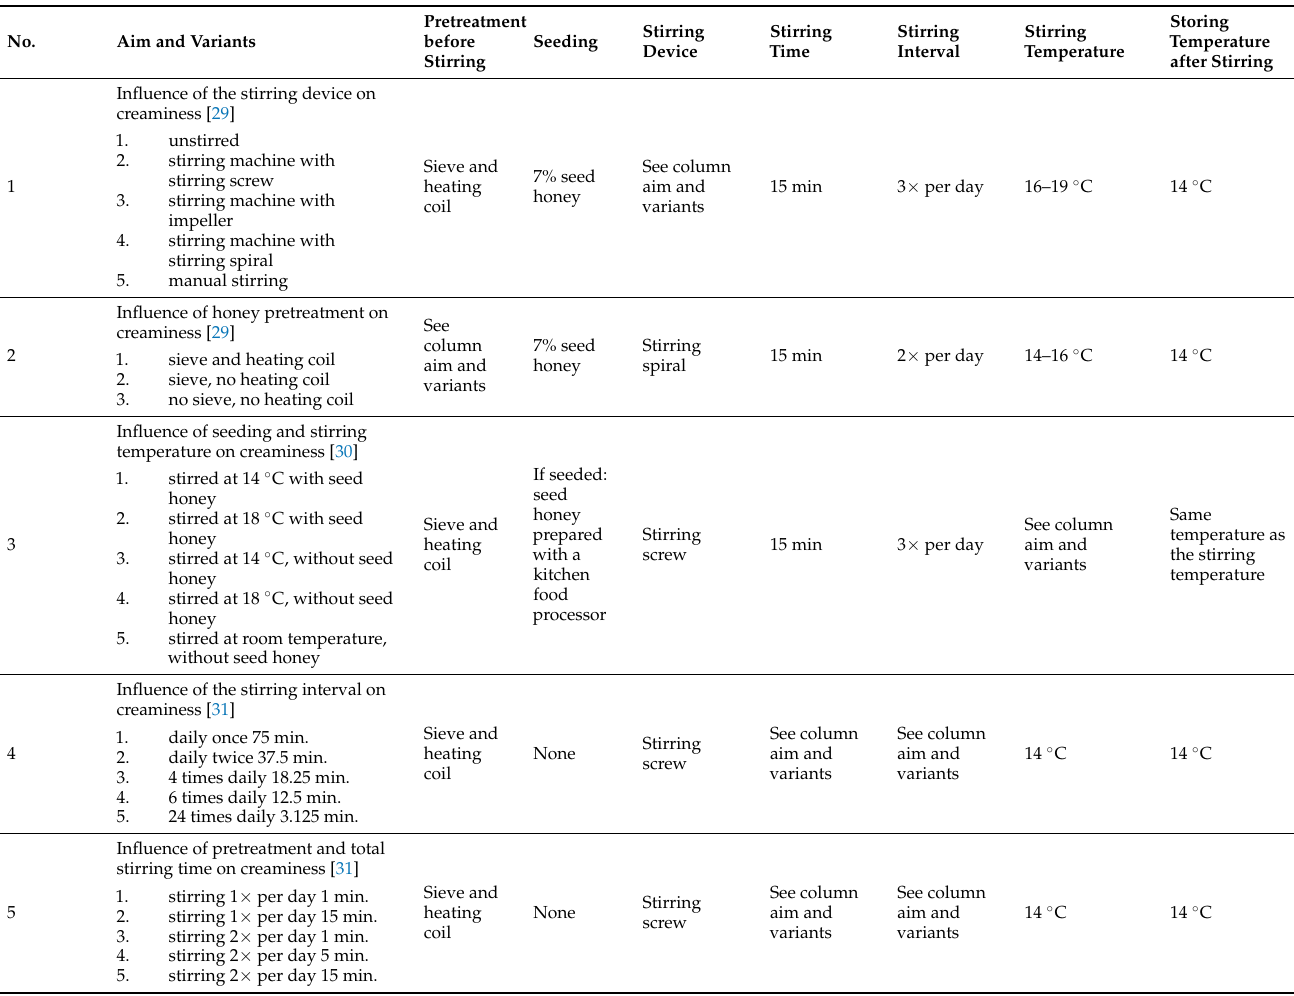
Table 1. Aim, variants and parameters of the stirring